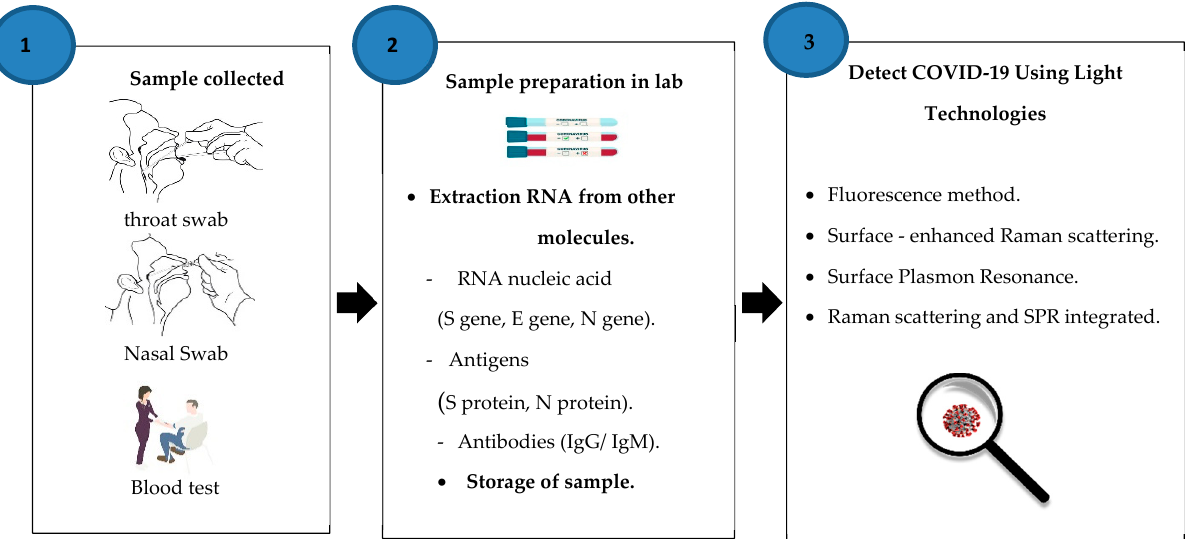
Figure 3. Steps to detect COVID-19 using light methods.